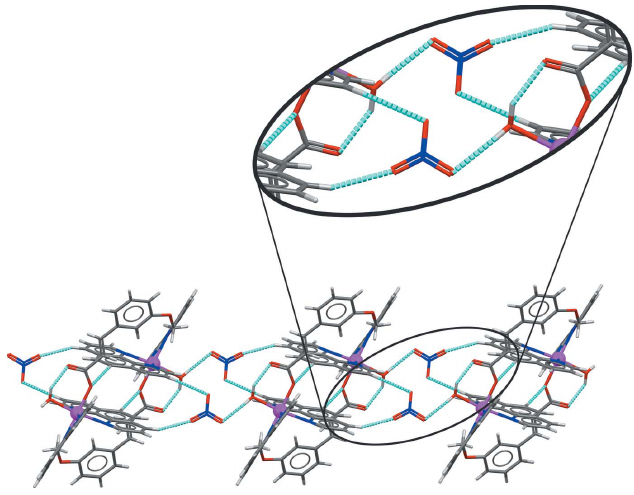
Figure 2 Crystal packing of the title compound shown in projection down the c axis illustrating chain formation along the c- axis direction by C—H (cid:2)(cid:2)(cid:2) O hydrogen bonding (shown as dashed cyan